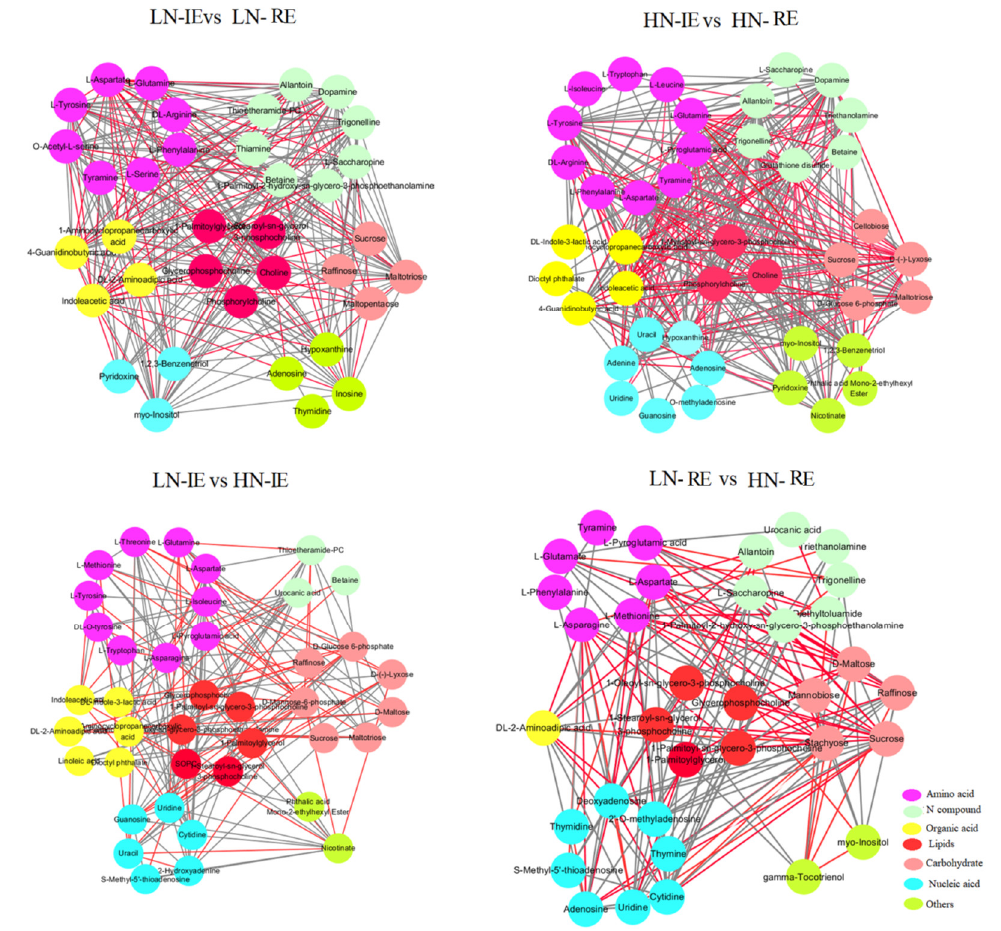
Figure 6. Network of metabolite-metabolite correlation based on significant correlations. Nodes stand for metabolites and edges stand for metabolite relationship. Red edges mean negative correlation, and grey edges mean positive correlation. The nodes in di ff erent color mean di ff erent metabolite type. HN-IE and HN-RE are samples from innermost endosperm region and the remaining endosperm region under high nitrogen treatment, respectively. LN-IE and LN-RE are samples from innermost endosperm region and the remaining endosperm region under low nitrogen treatment, respectively.